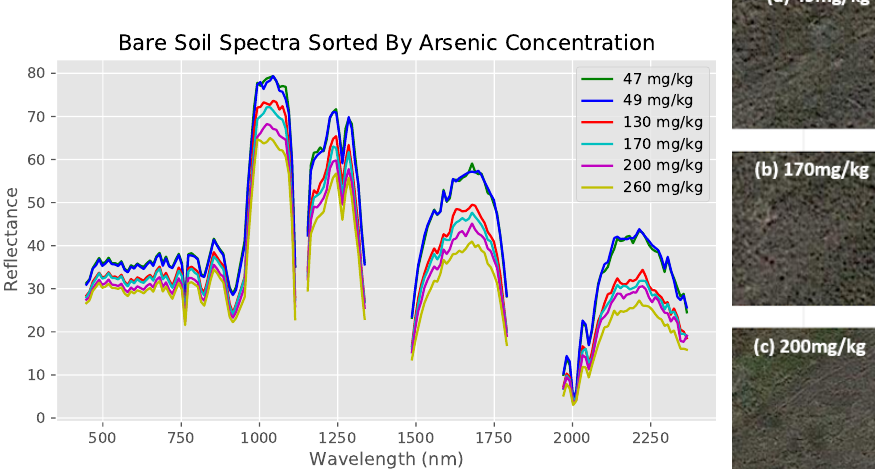
Figure 5. Comparing reflectance spectra of six bare soil locations with differing arsenic concentrations from ground measurements. Sites have similar soil composition and visual satellite appearance, as shown on the right.